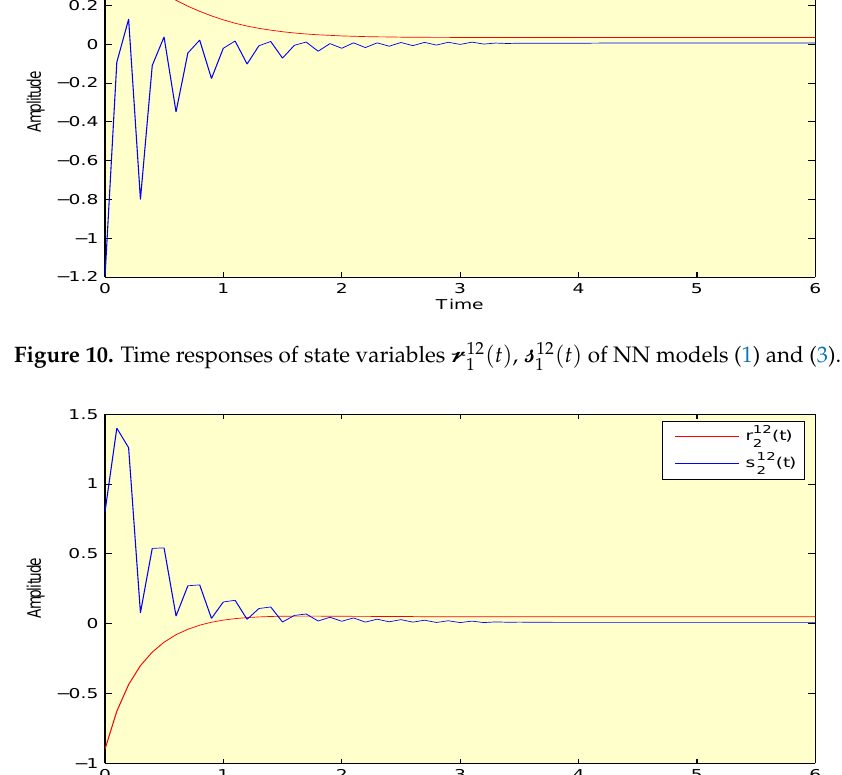
Figure 11. Time responses of state variables (cid:114) 12